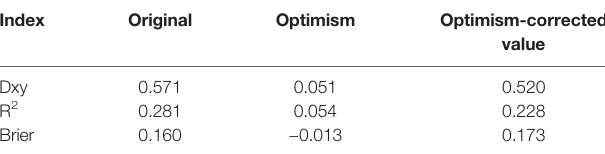
TABLE 4 | Performance of internal